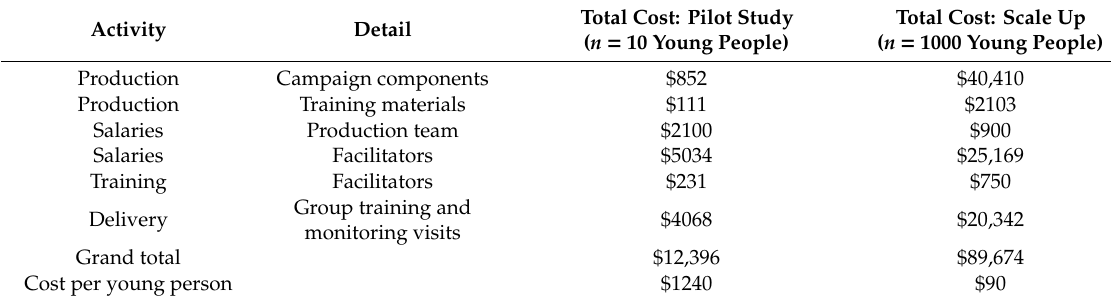
Table 4. Bishesta campaign pilot study costs versus at scale costs